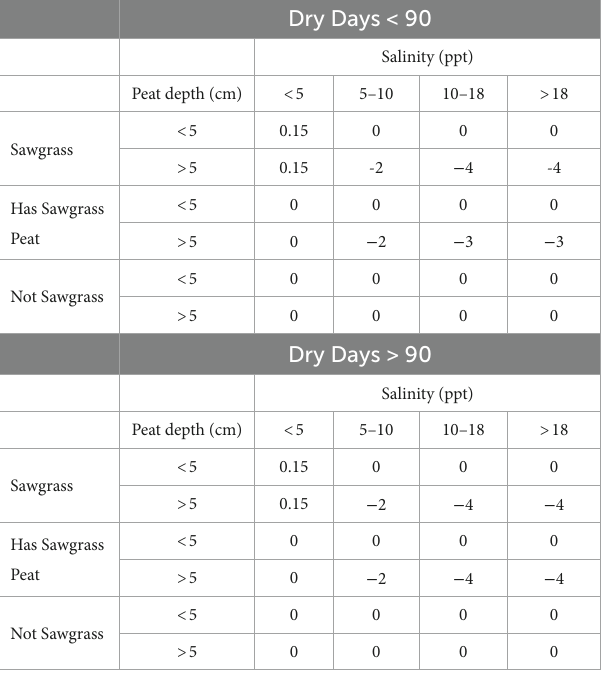
TABLE 1 Mean sawgrass peat accumulation values (cm) used in computation of joint conditional